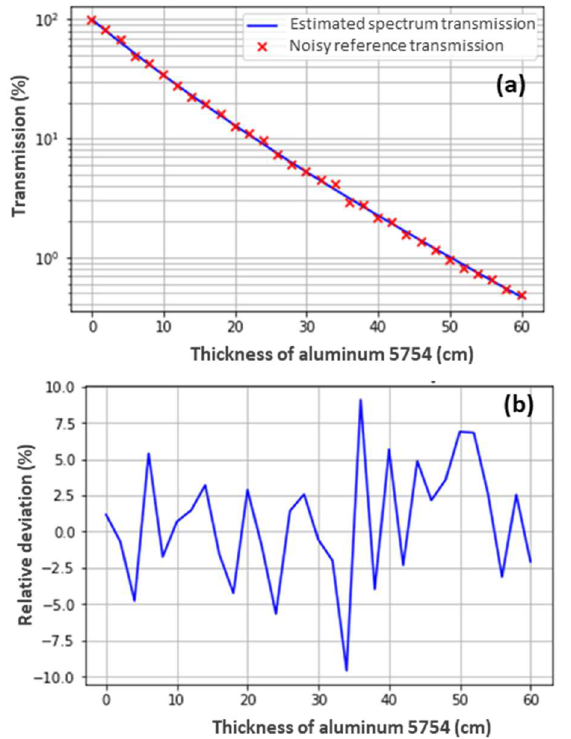
Fig. 8. (a): Transmission curve from modelling with noise (red dots) and transmission curve from the estimated spectrum (blue) - (b): Relative differences between the two transmission curves as a function of energy.